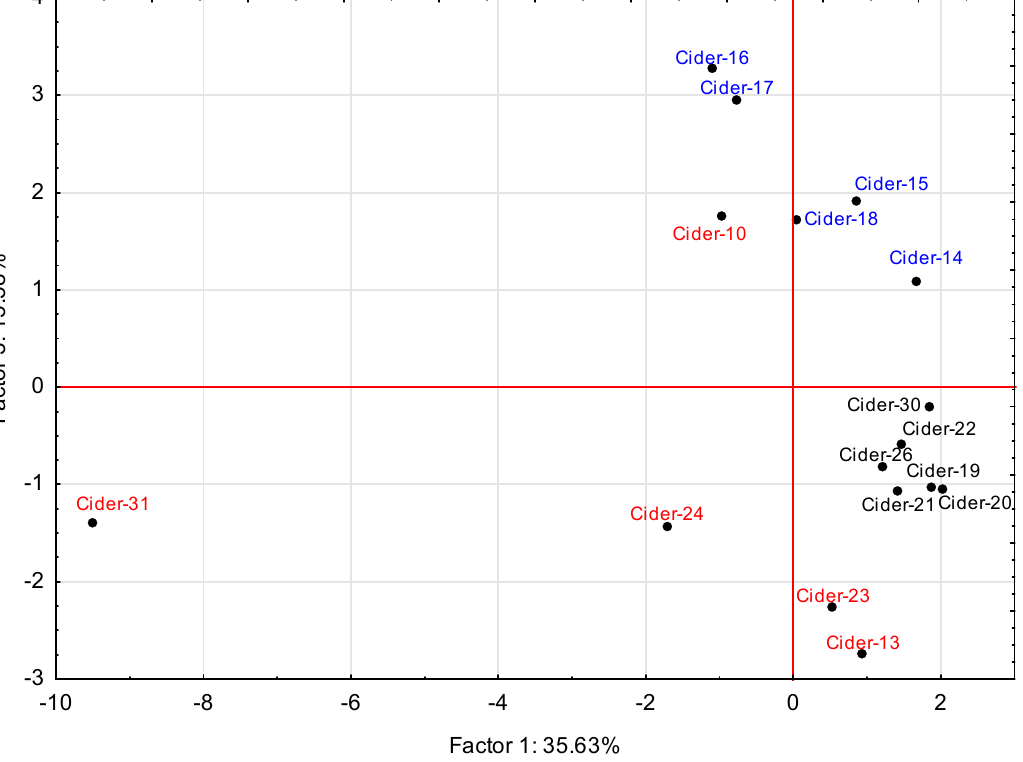
Figure 2. Principal component analysis of ciders fermented by different techniques: exclusively autochthonous culture (red); pure strains of Saccharomyces cerevisiae (blue); autochthonous culture with addition of pure strains of Saccharomyces cerevisiae (black), based on Table